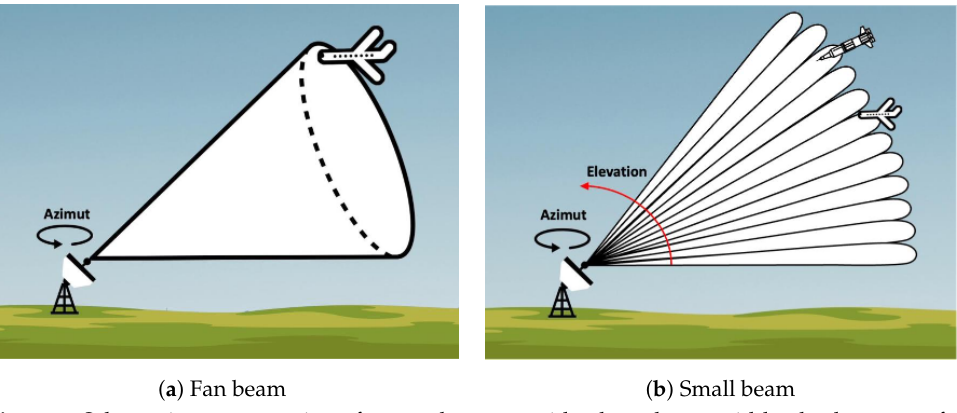
Figure 5. Schematic representation of two radars, one with a large beam width, also known as fan beam ( a ), the other with small beam width ( b ) and thus better directivity. The second radar can distinguish multiple objects in its field of